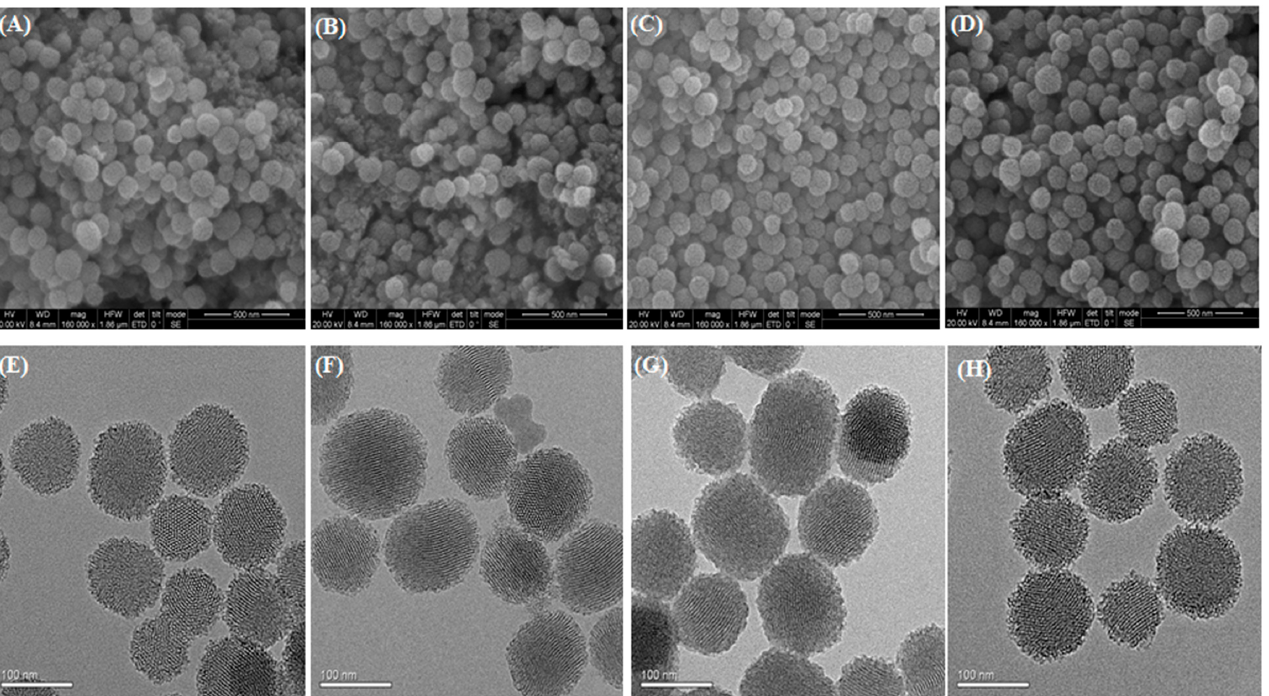
Figure 1. SEM images of FL-SiO 2 NPs-70 nm ( A ) and Me@FL-SiO 2 NPs-70 nm ( B ), FL-SiO 2 NPs-150 nm ( C ), and Me@FL-SiO 2 NPs-150 nm ( D ); TEM images of FL-SiO 2 NPs-70 nm ( E ) and Me@FL-SiO 2 NPs-70 nm ( F ), TEM images of FL-SiO 2 NPs-150 nm ( G ), and Me@FL-SiO 2 NPs-150 nm ( H ).